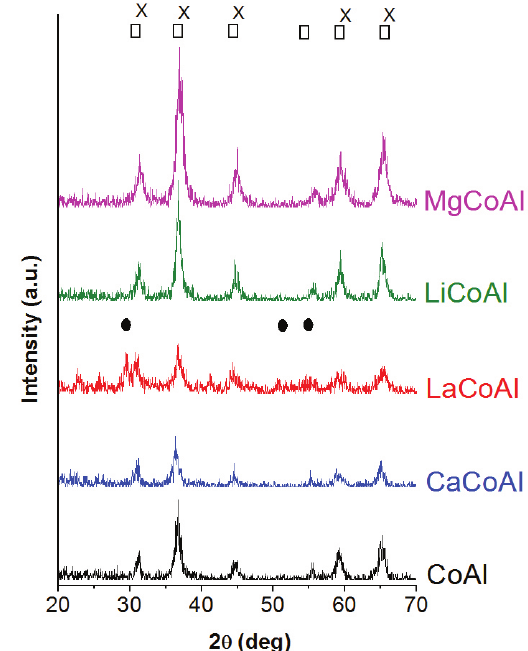
Figure 2. XRD patterns for calcined samples. Identified crystalline phases: ( □ ) Co O ; (X) CoAl O ; ( ● ) La O 3 4 2 4 2 3